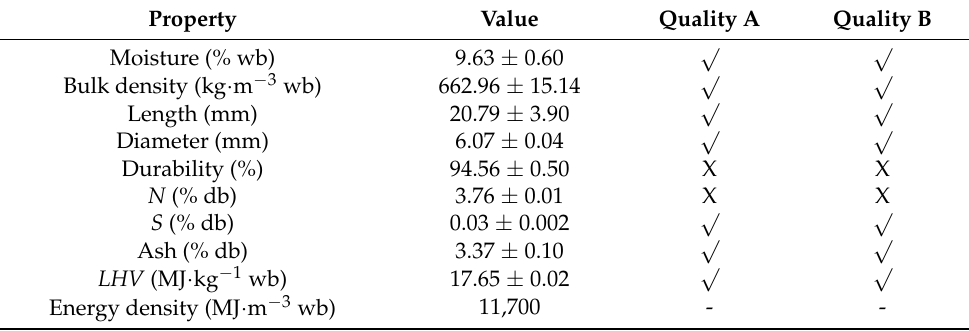
Table 5. Characterization of pellets from brewers’ spent